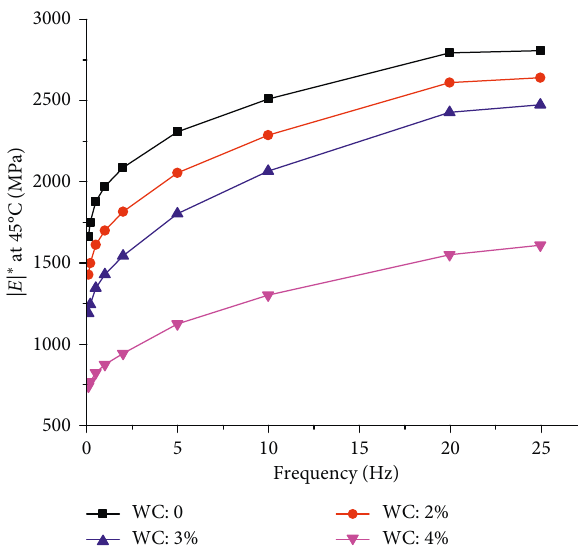
Figure 15: SBS#AC-20-type high-temperature dynamic modulus.